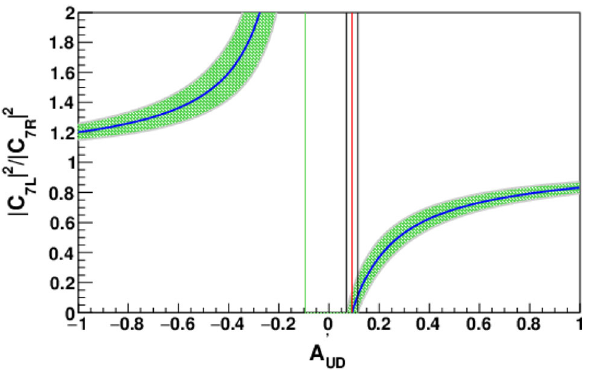
Fig. 7 Dependence of Wilson coefficient on ratio of up-down asym- metry, shown in the blue line, the green parts denote the consideration of uncertainties of A UD , the red solid line denotes A (cid:8) to the photon polarisation parameter predicted in SM, with the consid- eration of uncertainties of A UD shown between the black solid